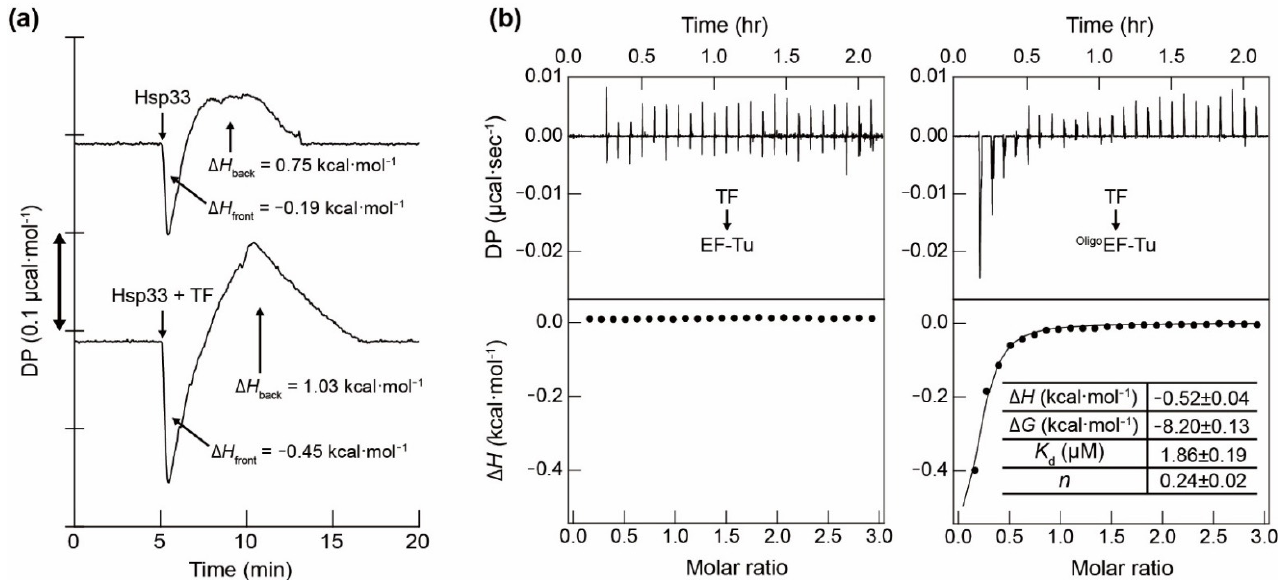
Figure 4. Calorimetric characterization of the TF binding to EF ‐ Tu. ( a ) ITC thermograms obtained by a single ‐ shot titration (added at 5 min of incubation at 33 ° C) of Hsp33 (upper) and equimolar Hsp33:TF mixture (lower) to EF ‐ Tu are shown. Differential power (i.e., heat flow) is denoted as DP. The earlier (negative) and later (positive) ITC peaks were indicated by Δ H front and Δ H back , respectively. ( b ) ITC thermograms (upper) obtained at 20 ° C by titrating TF to native EF ‐ Tu (left) and Oligo EF ‐ Tu (right) are shown with binding isotherms (lower), where the black line indicates a fitting curve and the inset table presents the thermodynamic parameters determined for the binding of TF to Oligo EF ‐ Tu.